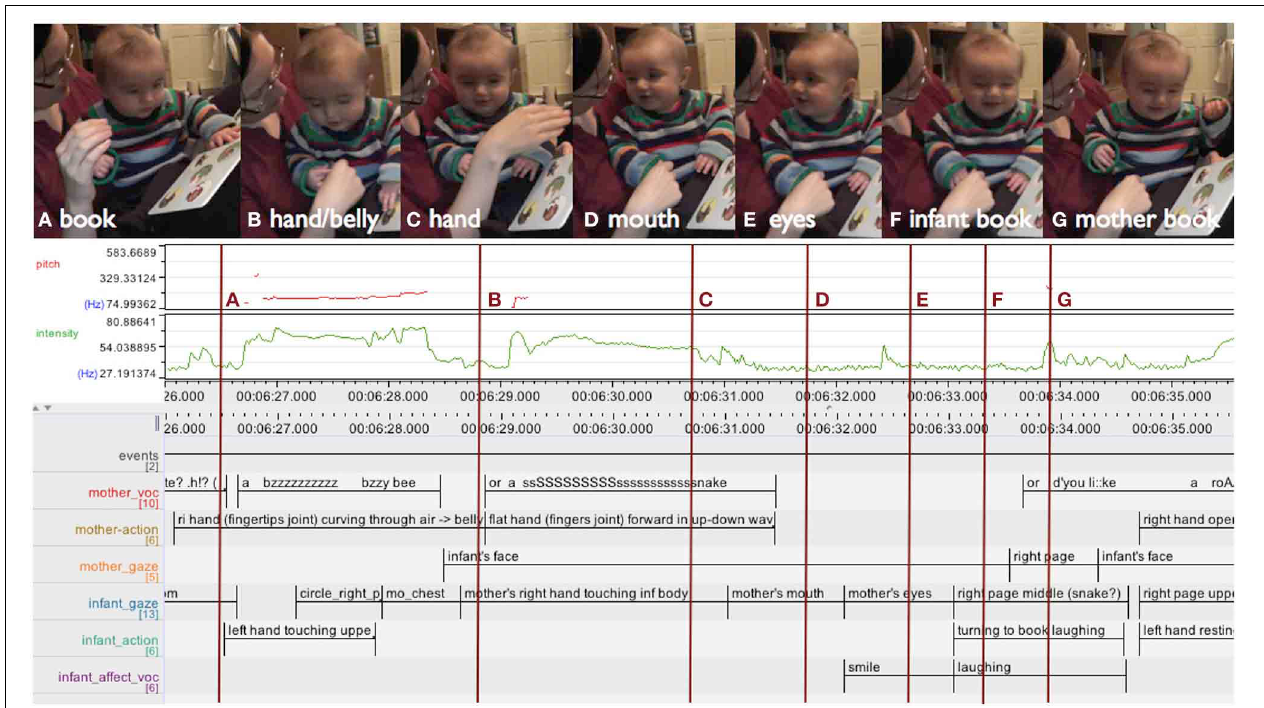
FIGURE 9 | ELAN analysis detail of book sharing interaction with 6-month-old infant sitting at a 90 ◦ angle on mother’s lap. Mother using extensive voice and hand acting to illustrate animals and animal sounds (“a bzzzzzz bzzzzy bee,” “a ssSSSSSSSSSssssssssssssnake,”